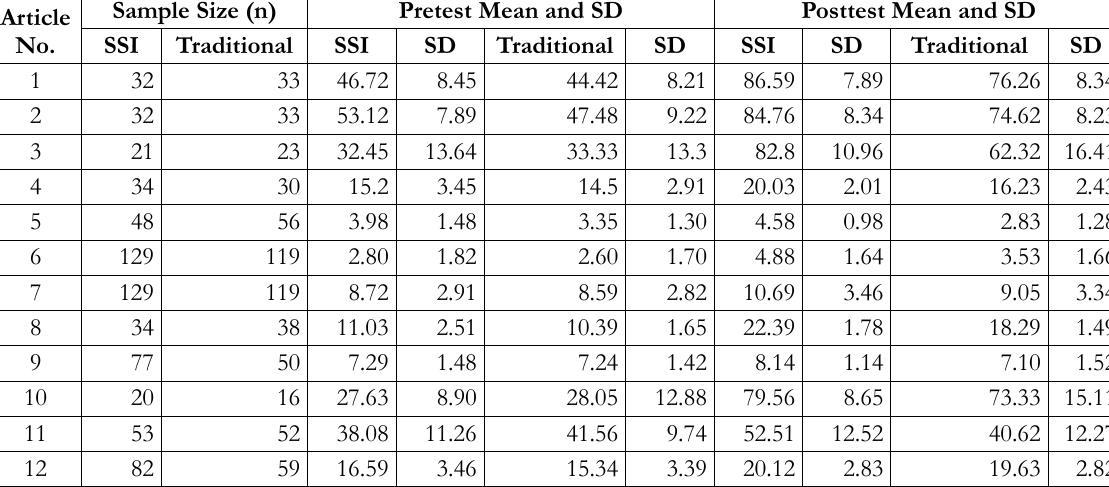
Table 4. Quantitative Data